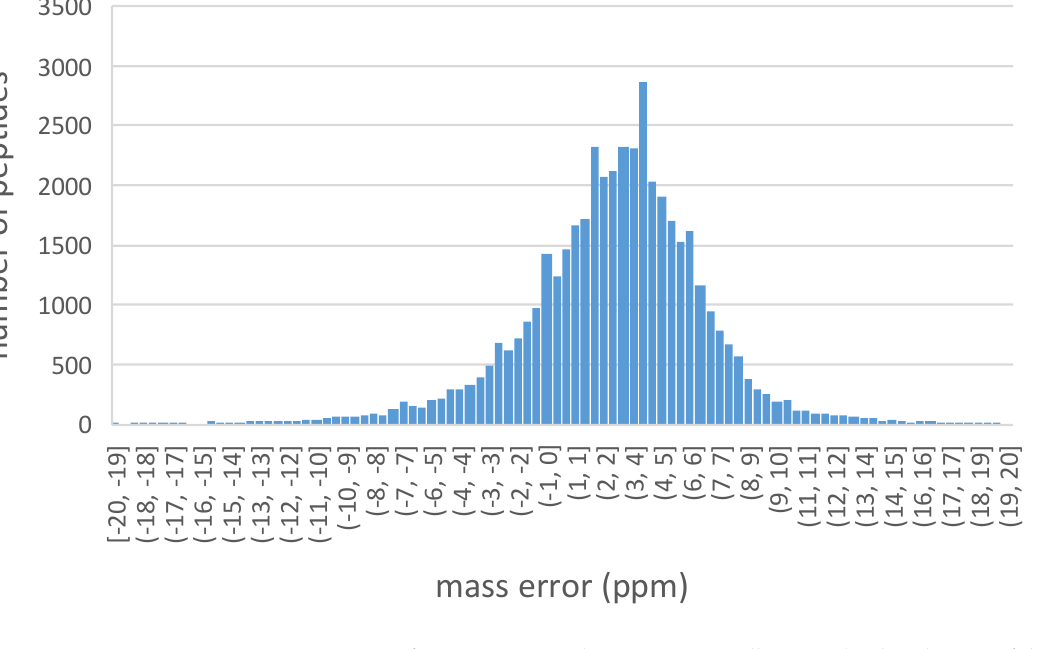
Figure 6. Mass errors of precursor peptides. Histograms illustrate the distribution of the number of peptides as reflected by precursor mass error (ppm) combined from all five gradient types.